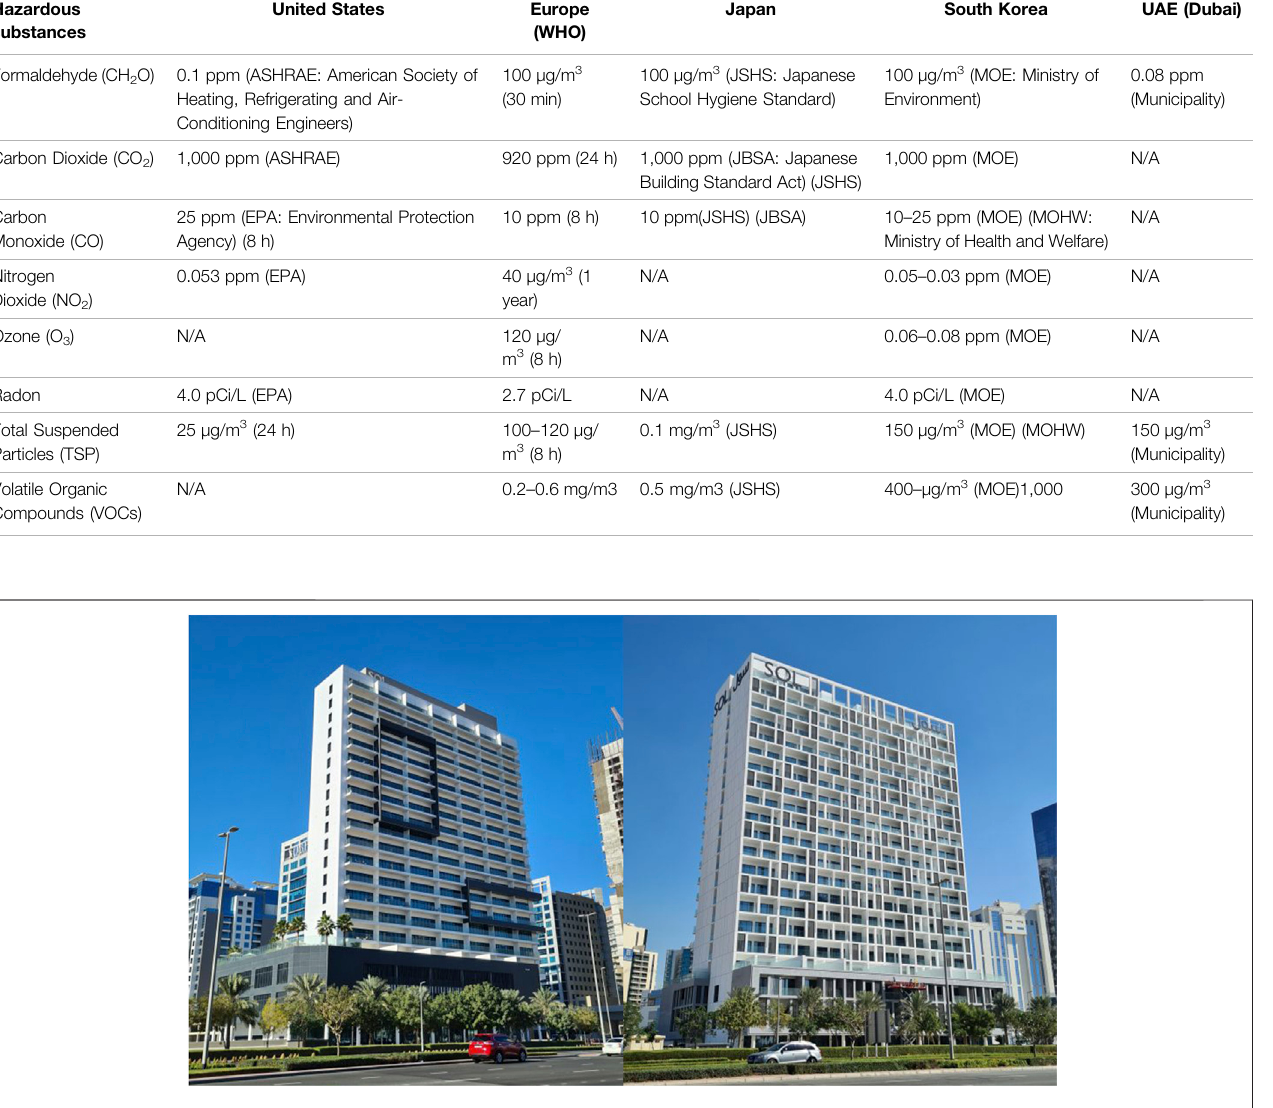
FIGURE 1 | Target apartments: Sol bay (A) and SOL avenue (B)